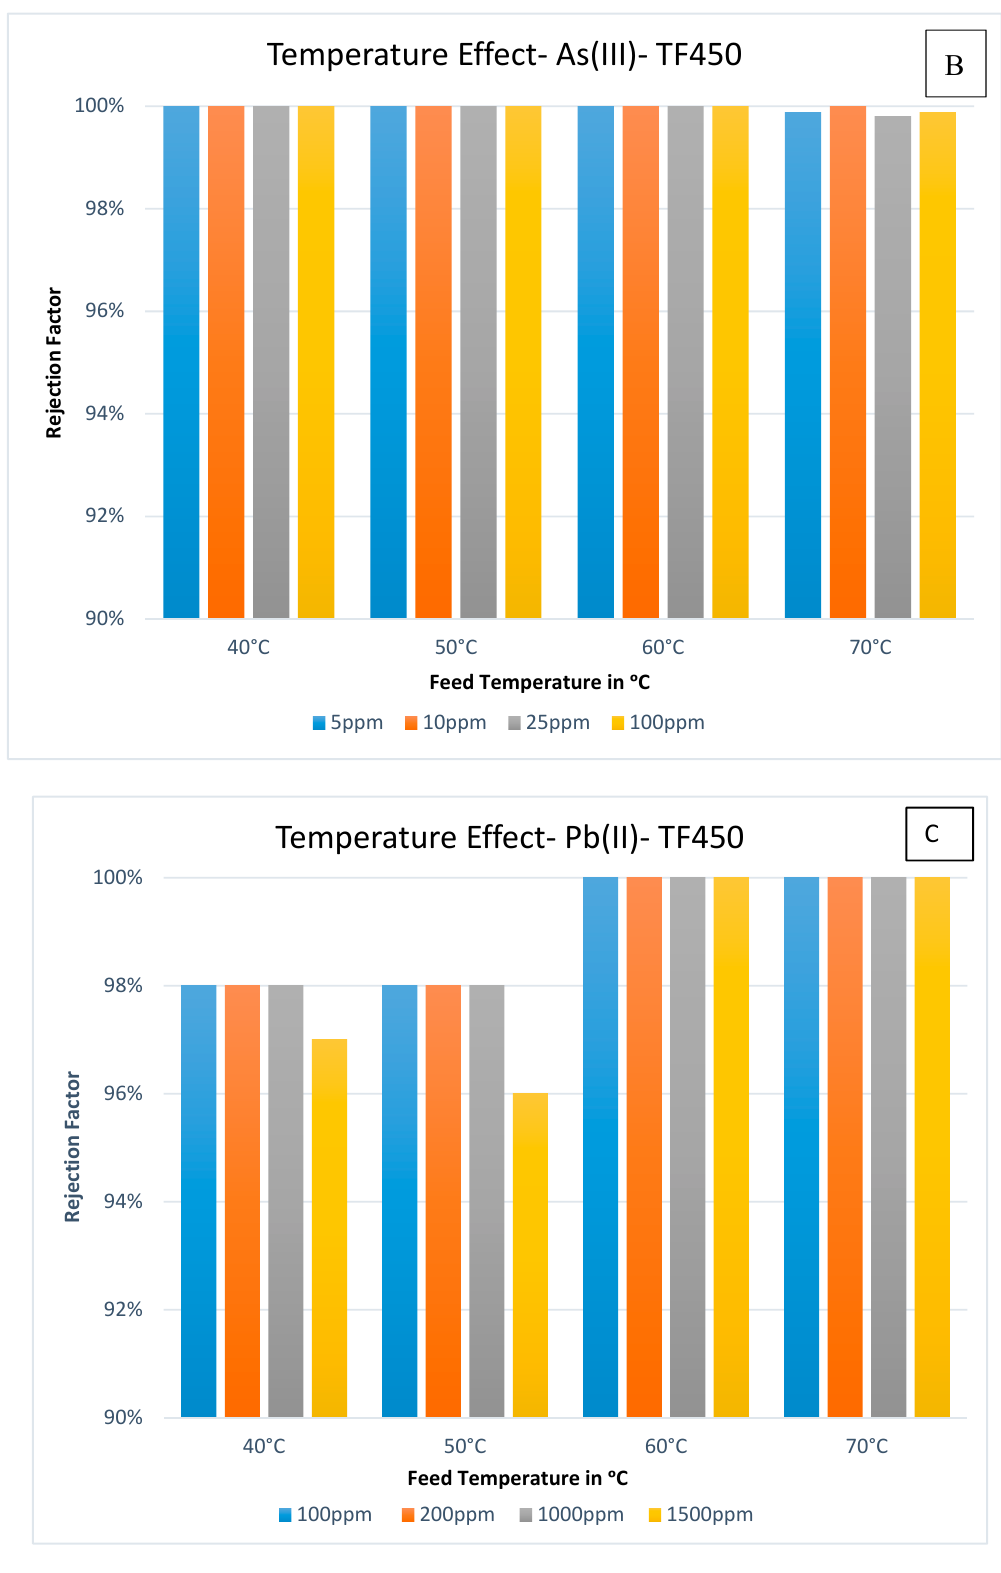
Figure 8. E ff ect of feed temperature on the rejection factor for TF450 membrane: ( A ) Hg(II), ( B ) As(III) Figure 8. Effect of feed temperature on the rejection factor for TF450 membrane: ( a ) Hg(II), ( b ) As(III) and ( C ) Pb(II) (coolant temperature = 10 ◦ C, flow rate = 3 L / and ( c ) Pb(II) (coolant temperature = 10 °C, flow rate = 3 L/min).